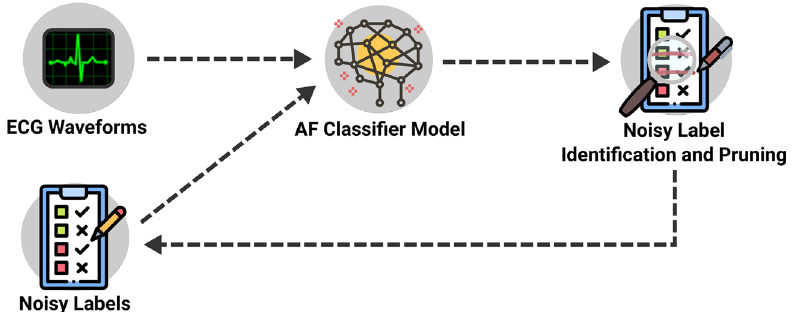
Figure 3. Overview of weak supervision with confident learning. Network predictions are combined with weak labels to generate the confident joint, Which in turn is used to identify potentially incorrect labels for cleaning. The set of cleaned labels is used for further